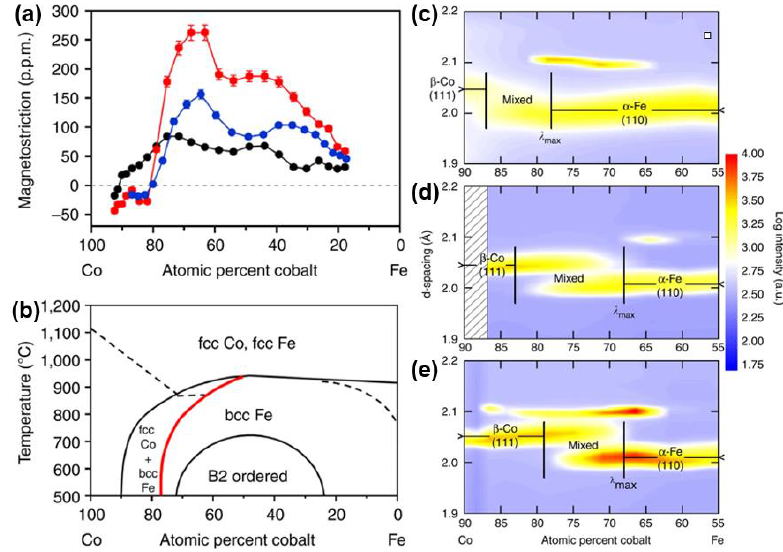
Figure 19. ( a ) Magnetostriction variation versus atomic percent cobalt for three differently prepared Co 1−x Fe x composition spreads, as-deposited (black dots), slow-cooled (blue dots), quenched (red dots). ( b ) Co–Fe- phase diagram. The red curve highlights the approximate phase boundary between (fcc Co + bcc Fe) and bcc Fe. ( c )-( e ) Intensity plots of the synchrotron microdiffraction of Co 1−x Fe x thin films. ( c ) as-deposited, ( d ) annealed and slow-cooled, ( e ) annealed and water-quenched composition spread samples. The black line marked λ max in each spread indicates the approximate composition of the (fcc + bcc)/bcc phase boundary. Reprinted with permission from [119]. Copyright [2011], Springer Nature.